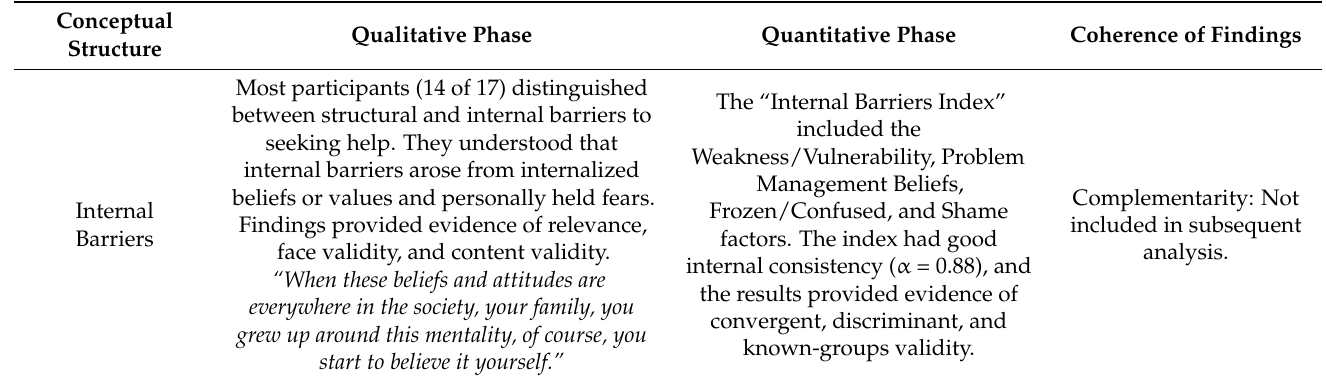
Table 3. Joint display of the coherence of findings for internal barriers to help